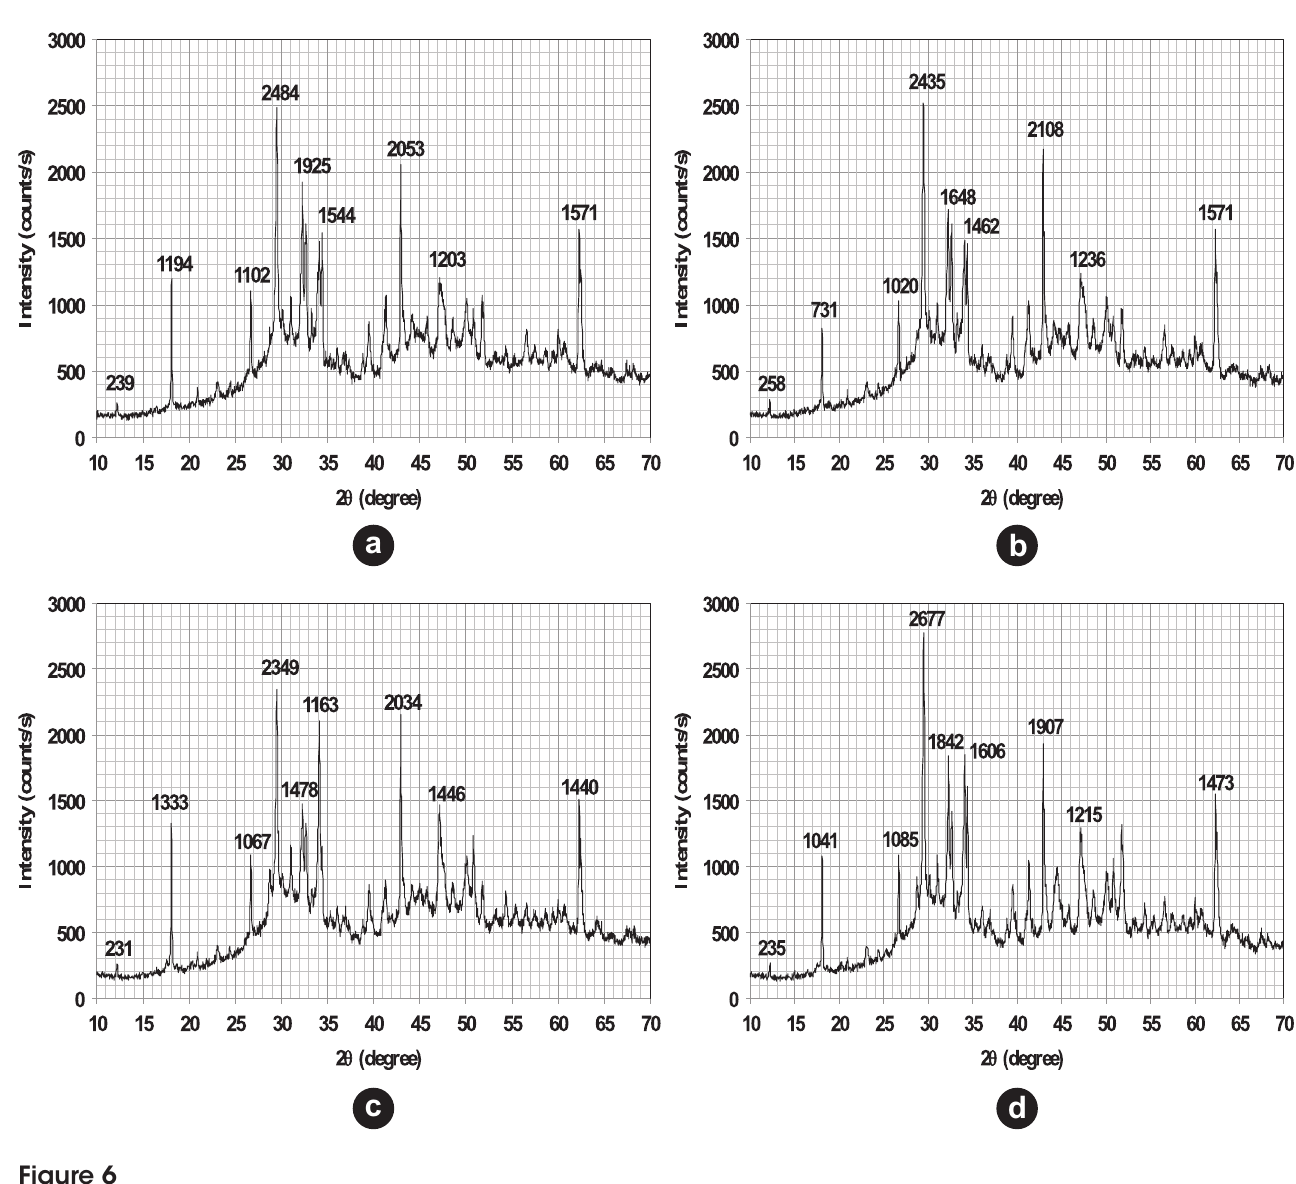
Diffractograms (a) 11 nS; (b) 6 nS; (c) 3 nS; (d) 1.7